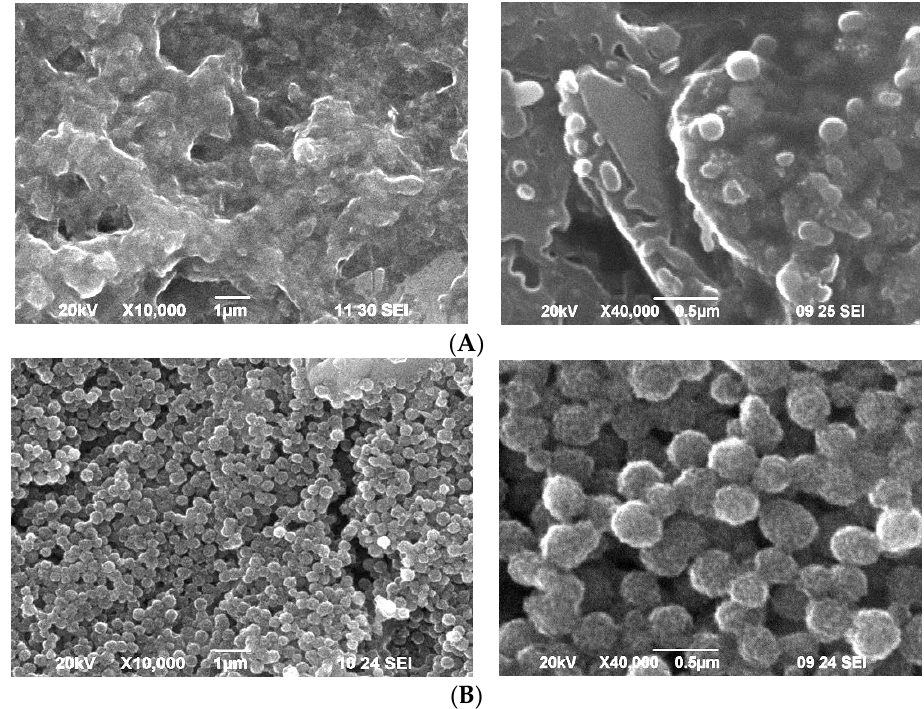
Figure 1. SEM images of PANI dispersions obtained with different stabilizers: ( A ) — stabilizer PVP; ( B ) — stabilizer SiO 2 .